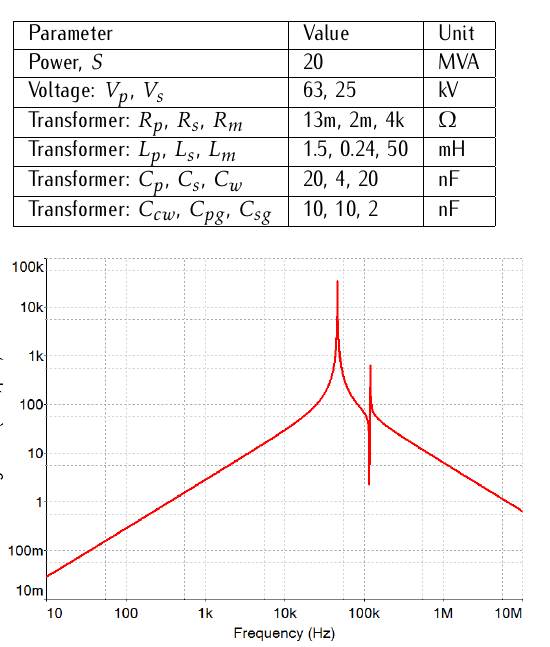
Table 1. Transformer parameters (in p.u.) used in Fig. 2.